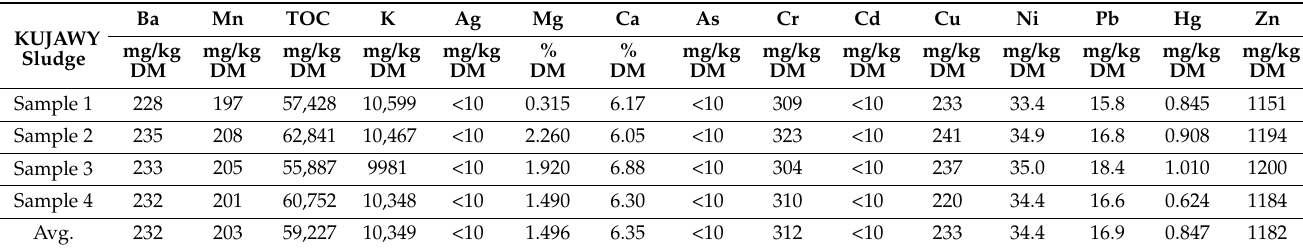
Table 1. Characteristics of digested sludge from a separate fermentation chamber at the Kujawy sewage treatment plant, the dry matter content in the sludge is 3% (Source: Project Nr POIR.04.01.04- 00-0039/17).